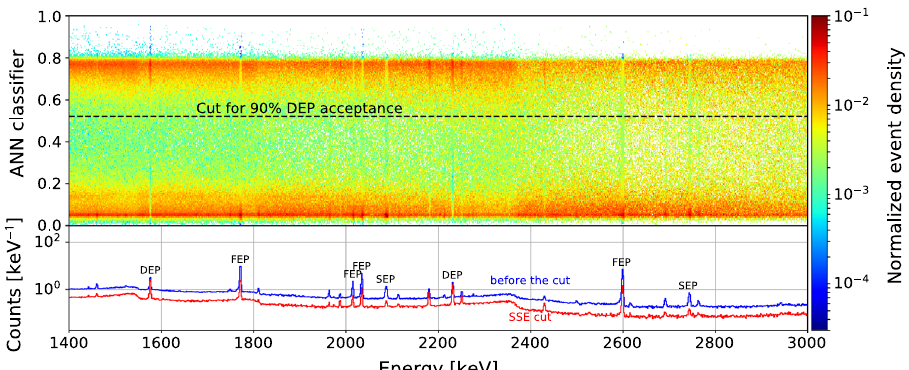
Fig. 9 2D histogram showing the classified 56 Co events distribution. Vertical axis corresponds to the classifier value (ANN) and the hori- zontal one to the reconstructed energy. The bottom panel shows the corresponding energy spectra (before/after the cut). Two bands with Fig. 10 Close-up of the 56 Co spectrum before and after the cut rejecting MSEs (the same spectrum as in the bottom panel of Fig. 9), showing the effect of the PSA method on peaks consisting of events of different types. Suppression of MSEs in SEPs and FEPs is clearly visible, while SSEs in the DEPs are mostly